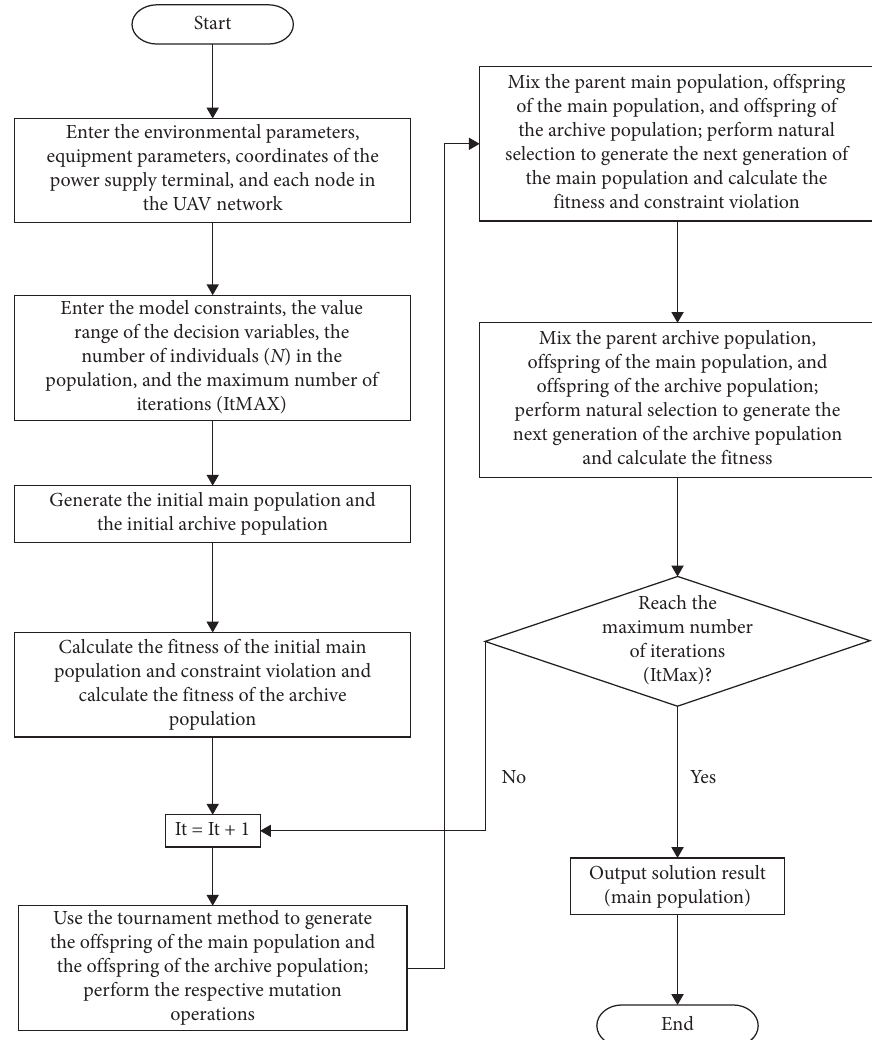
Figure 2: Flowchart of the solution based on CCMO.